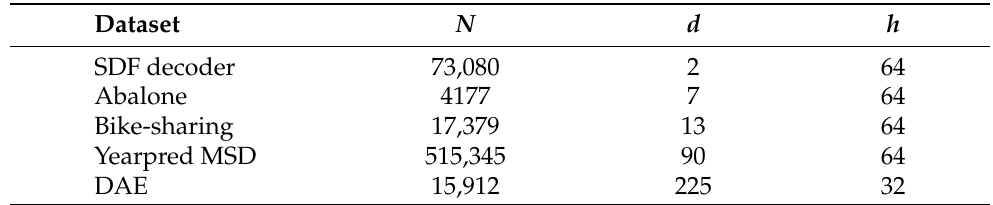
Table 2. The real datasets used in the experiments with their number of observations n and feature dimension d . Also shown is the number of NN hidden nodes h used in